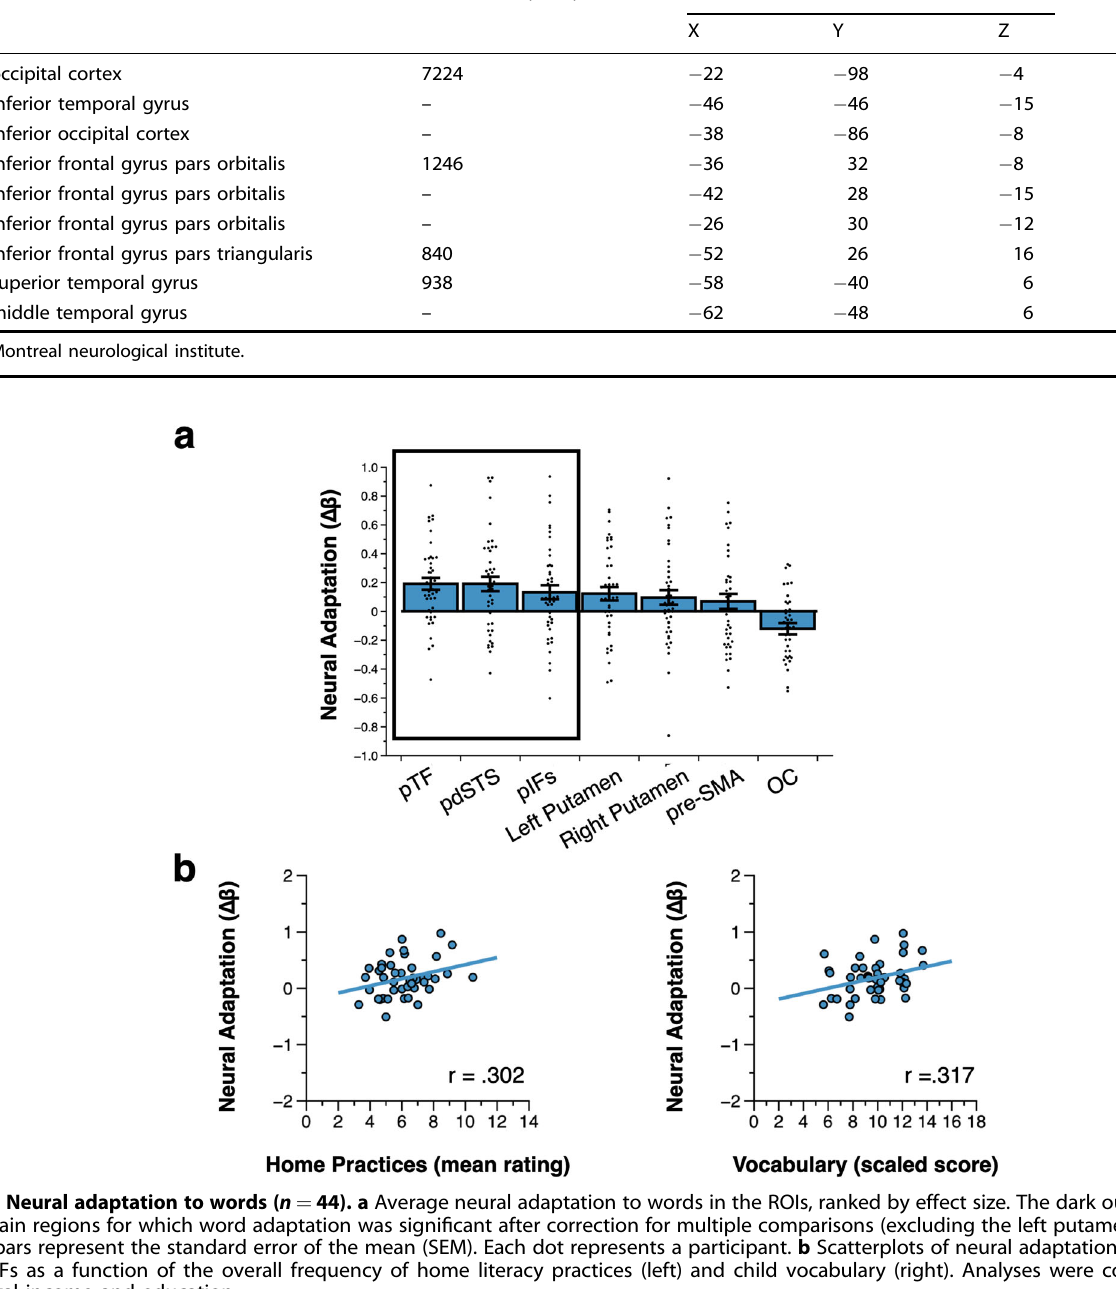
Table 2. Activation peaks in the whole-brain analysis of the word adaptation task. Anatomical Location